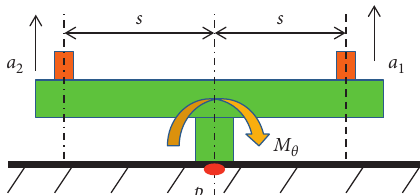
Figure 5: Finite difference method for measuring rotational degree of freedom.